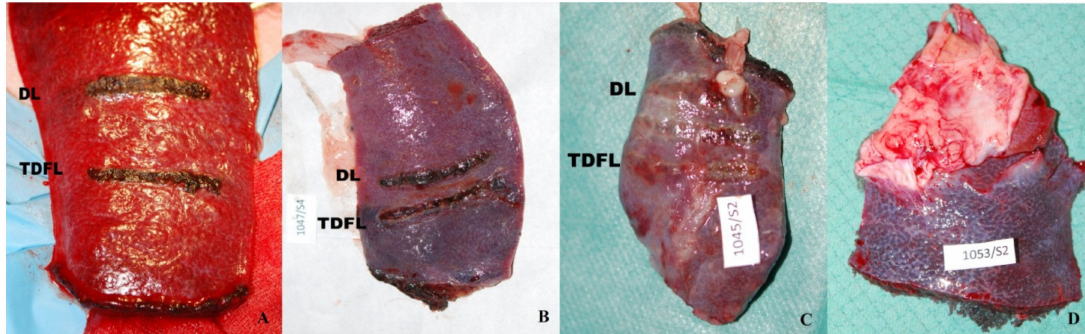
Figure 2. Macroscopical appearance of the spleen in pigs after incisions made with a thulium-doped fiber laser (TDFL) and a diode laser (DL). ( A ) On the day of surgery, ( B ) on day 7 post-surgery, ( C ) on day 14 post-surgery, ( D ) and the site of partial resection of the spleen with the diode laser (DL) 14 days